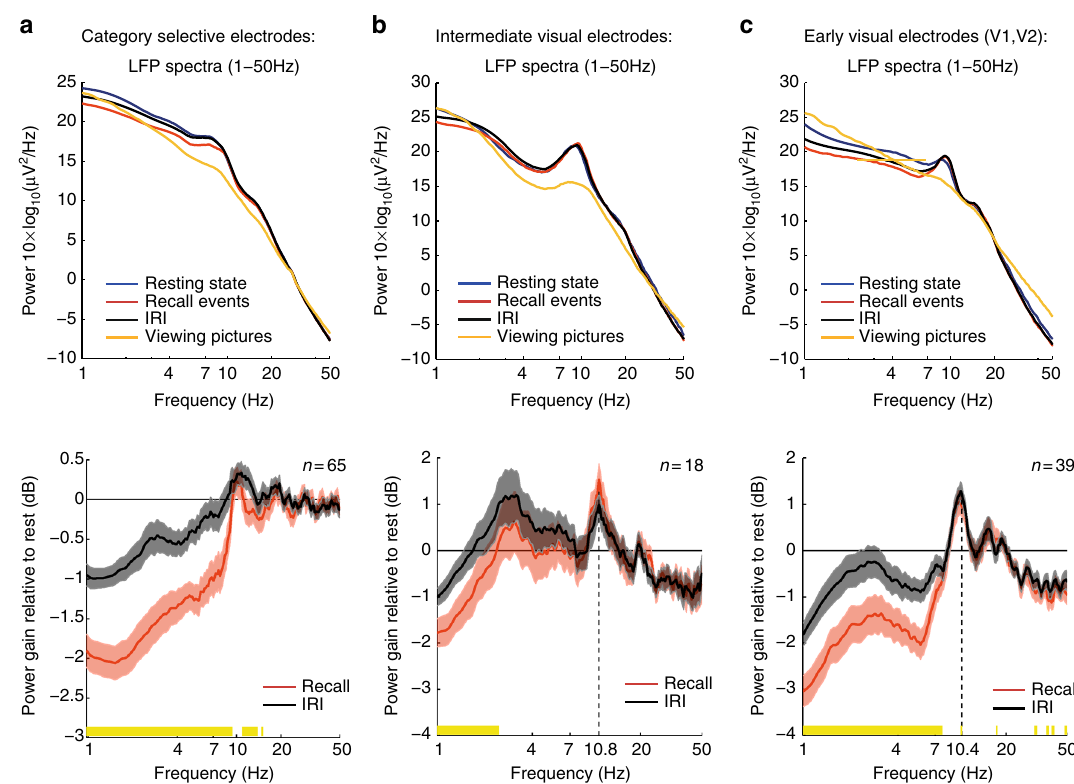
Fig. 8 Spectral analysis of the raw LFP signal (1 – 50 Hz) during recall, inter-recall intervals, and picture viewing. Spectral analysis of the raw LFP signal during resting-state (blue), recall events (red), inter-recall intervals (black), and picture viewing (orange). The bottom row depicts power gain relative to resting- state. a Category selective electrodes: note the signi fi cant power decrease between 1 – 9 Hz and 11 – 15 Hz during recall events in comparison to IRI (signi fi cant frequencies are marked in yellow: p < 0.05, FDR corrected, signed-rank test). In contrast to early and intermediate visual electrodes, there was no increase in the alpha band (8 – 12 Hz) relative to rest. b Intermediate non-category-selective visual electrodes manifested a recall-related power decrease that was restricted to the delta band (1 – 4 Hz; signi fi cant frequencies are marked in yellow). Comparing recall events and IRI to resting state revealed a signi fi cant power increase in the alpha band (peak frequency: 10.8 Hz, p < 0.05, FDR corrected, signed-rank test). c Early visual electrodes (V1 and V2) manifested a recall-related power decrease between 1 and 8 Hz (signi fi cant frequencies are marked in yellow), and a signi fi cant power increase in the alpha band relative to rest (peak frequency: 10.4 Hz, p < 0.05, FDR corrected, signed-rank test). Note that power increase in the alpha band was signi fi cantly higher during recall compared to IRI ( p < 0.05, FDR corrected, signed-rank test). Shaded areas represent